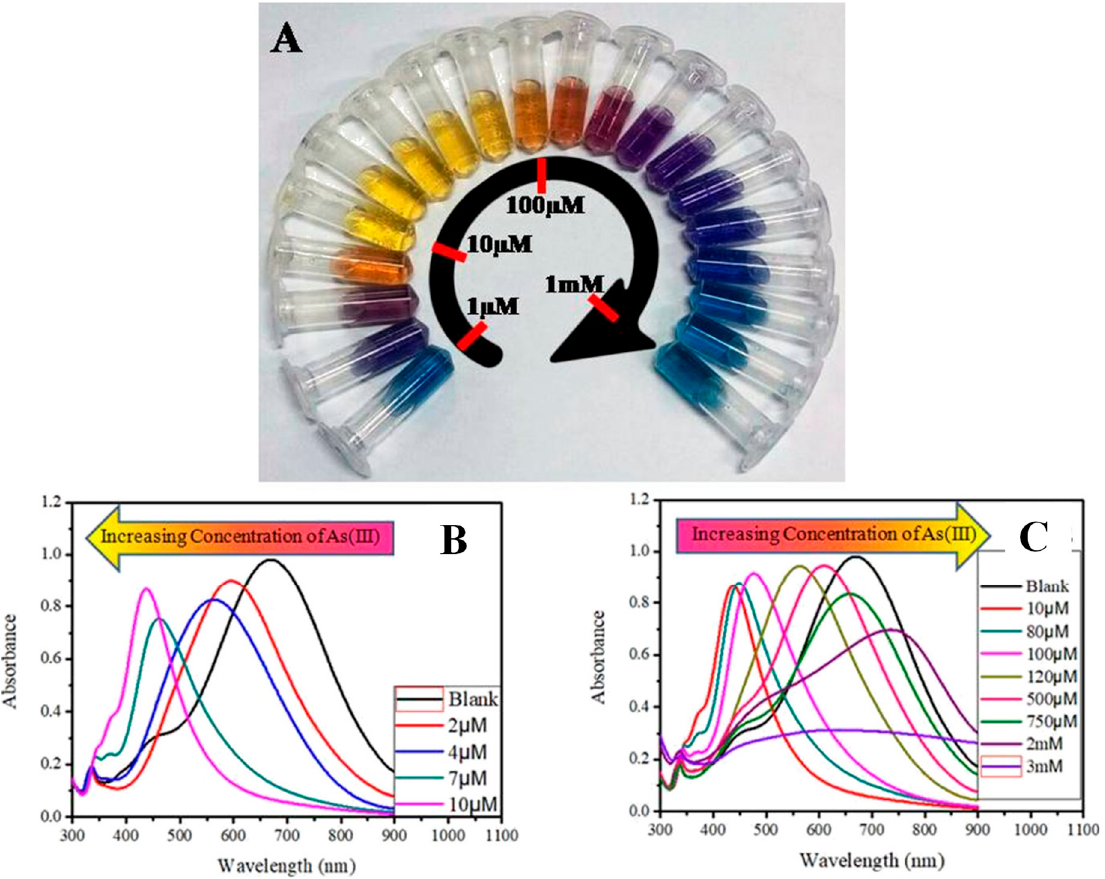
Figure 6. ( A ) Concentration-dependent color-coded sensing of arsenic (III) between the concentration range of 10 –6 to 10 –3 M, ( B ) tuning of SPR as a result of morphological change of AgNPr at different concentrations of arsenic (III) between 10 –6 and 10 –3 M where ( B ) shows the variation of plasmon band at different lower concentrations of arsenic (III) in the range of 0.0–10.0 μ M (0.0 μ M (blank): black trace ( λ max = 704 nm), 1.0–2.0 μ M: blue trace, 2.0–4.0 μ M: orange trace, 5.0–7.0 μ M: red-violet trace, 8.0–10.0 μ M: blue-violet trace) and ( C ) at different higher concentrations of arsenic (III). The plasmon band, and hence the color of the nanomaterials, changes in a distinct manner, where a specific color remains unchanged in a broader range of growing concentrations such as: 10.0–80.0 μ M: yellow, 90.0–100.0 μ M: orange, 110.0–200.0 μ M: dark red, 250.0–500.0 μ M: purple, 750.0 μ M to 2 mM: different shades of blue, 3–10 mM: faded blue, and above 10 mM the color becomes faint blue to grey or almost colorless [69]. Copyright 2019, reproduced with permission from American Chemical Society, Washington, DC,